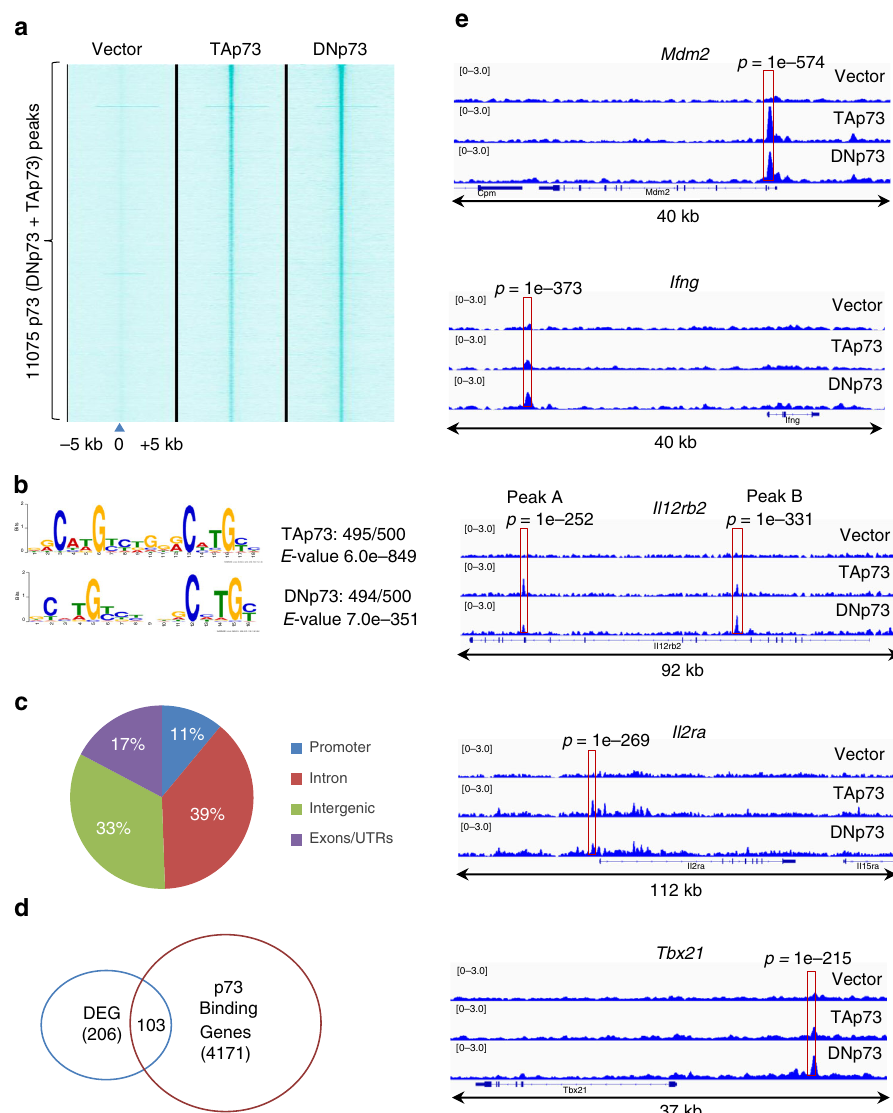
Fig. 4 Discovery of p73 direct target genes. a – e p73-speci fi c binding sites were found via ChIP-Seq analysis from Th1 cells in which FLAG-tagged TAp73 or FLAG-tagged DNp73 was expressed. a Each column represents p73 binding in empty vector (EV), FLAG-tagged TAp73, or FLAG-tagged DNp73 within a 10-kb window [ − 5k, 0, + 5k], centered on the p73-binding summits (indicated as position “ 0 ” ). The intensity of p73-binding peaks is indicated by the intensity of cyan color, whereas “ white ” represents no binding. b The consensus motif for p73 was derived from the top 500 p73-binding summits using MEME. c Shown is genome-wide distribution of p73-binding sites at introns, intergenic regions (de fi ned according to RefSeq), promoter regions (15 kb 5 ′ of the transcription start site), and exons/UTRs regions. d Venn diagram of genes differentially expressed upon p73 overexpression and/or directly bound by either TAp73 or DNp73. e The gene tracks represent TAp73- and DNp73-binding sites found by ChIP-Seq analysis using anti-FLAG at the Mdm2 , Ifng , Il12rb2 , Il2ra , and Tbx21 loci. For each peak, the P value was calculated using a dynamic Poisson distribution to capture local biases in read background. Three independent ChIP-Seq experiments were performed; representative results are